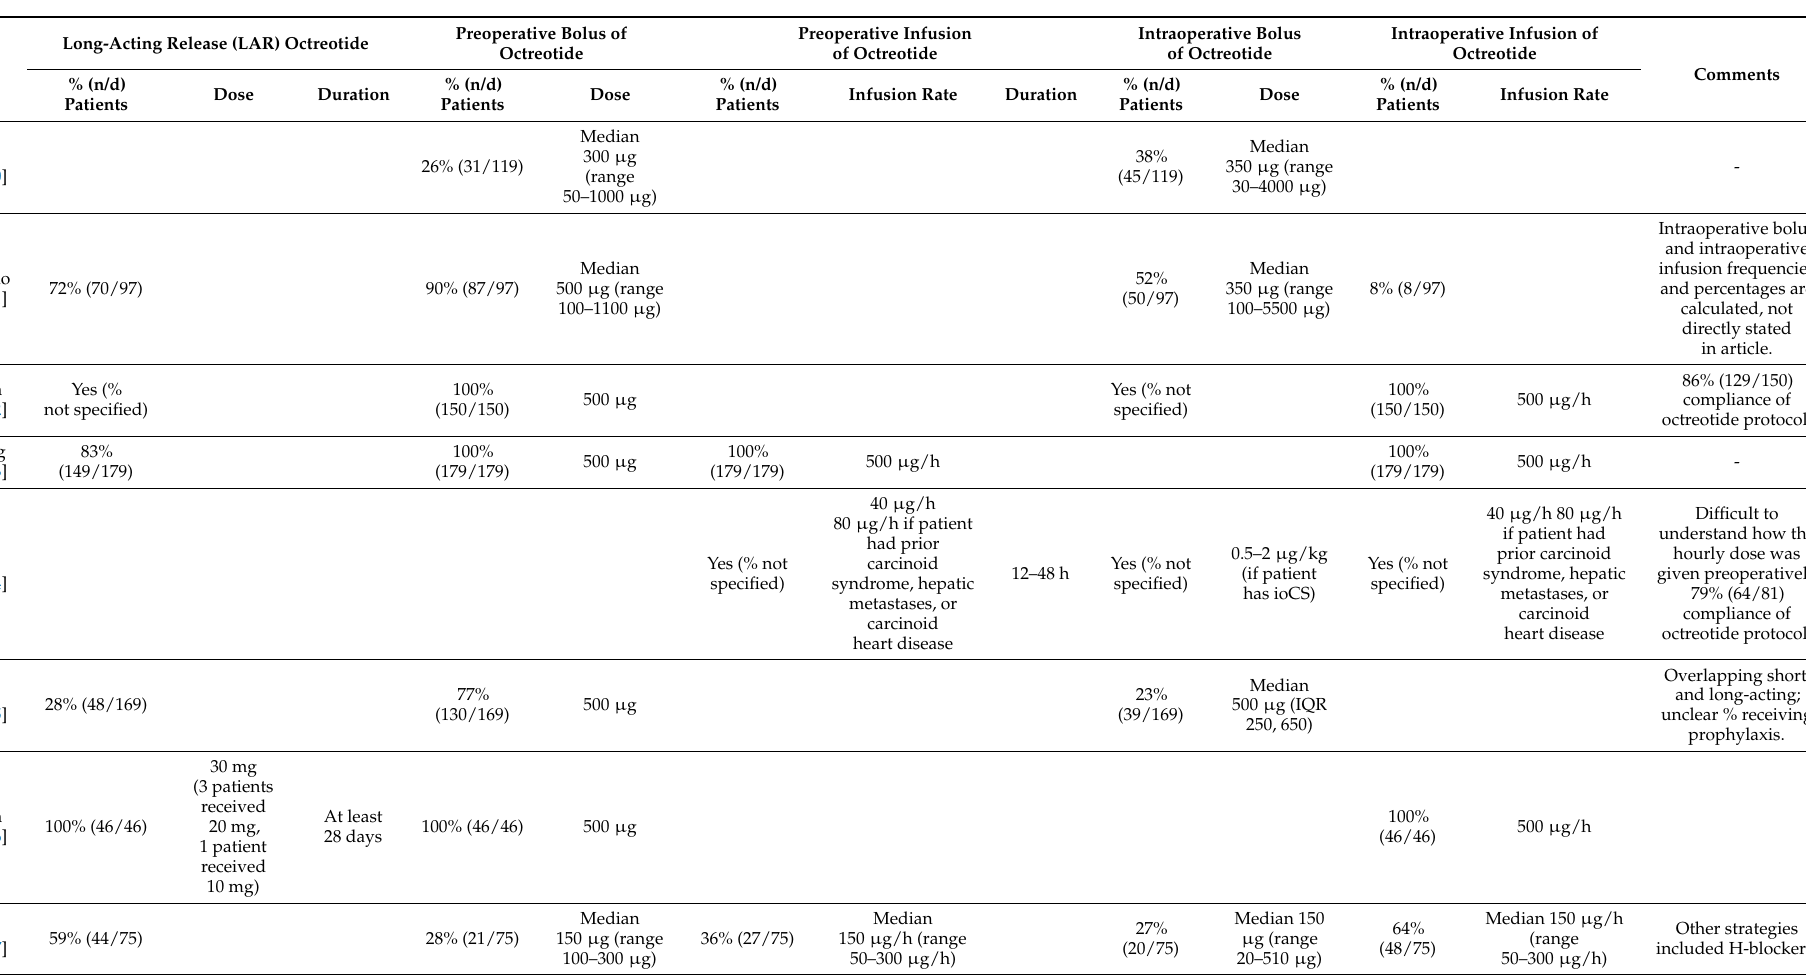
Table A2. Summary of octreotide use across studies. Includes use of long-acting somatostatin receptor analogues, short-acting octreotide prevention, and treatment regimens (dose and